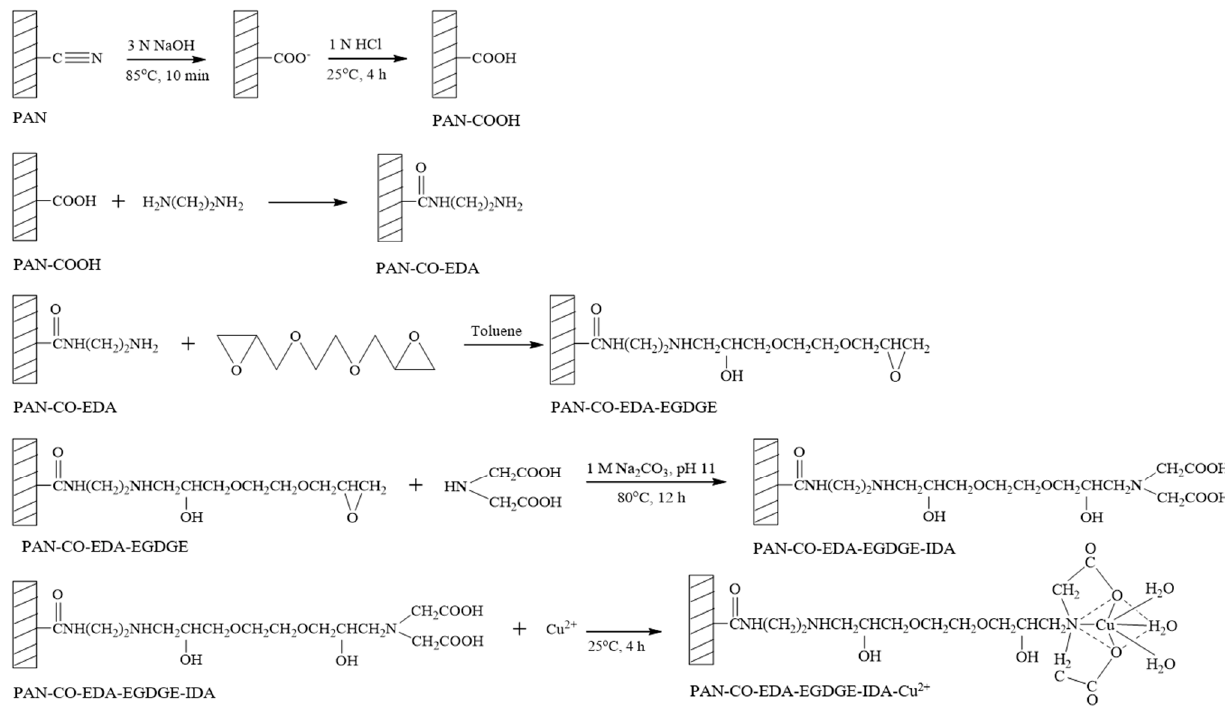
Figure 2. Modification steps of PAN membrane for the preparation of IMAM.